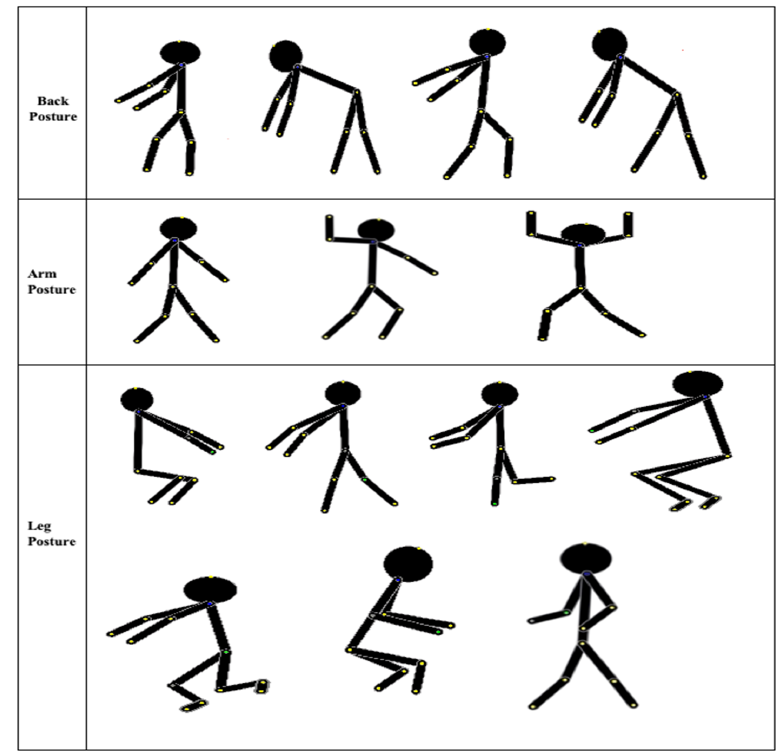
Figure 6. Standard working postures in the OWAS method.